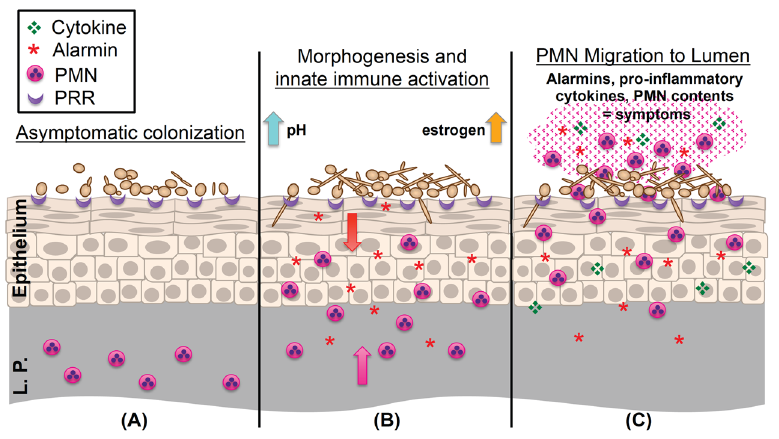
Figure 1. Working model of the immunopathogenesis of C.albicans vaginitis. ( A ) Yeast forms of C. albicans asymptomatically colonize the vaginal epithelium despite the presence of numerous pattern recognition receptors (PRR) on the epithelial surface. ( B ) C. albicans begins to undergo the yeast-to-hypha switch under morphogenesis-inducing conditions (increases in estrogen, elevated vaginal pH, and microbiota disruption). Augmented recognition by PRRs, increased hyphal biomass, and expression of hypha-associated virulence factors elicits inflammatory signaling (S100A8/9 alarmins and proinflammatory cytokines) in the vaginal epithelium, resulting in initial migration of PMNs from the lamina propria (L.P.) to the vaginal lumen. ( C ) Failure to adequately reduce immunopathological triggers results in the continued expression of innate immune effectors by the vaginal epithelium. These initial signals, coupled with secondary amplification of immune effectors by recruited PMNs, contribute to symptomatic infection and characteristic immunopathology.